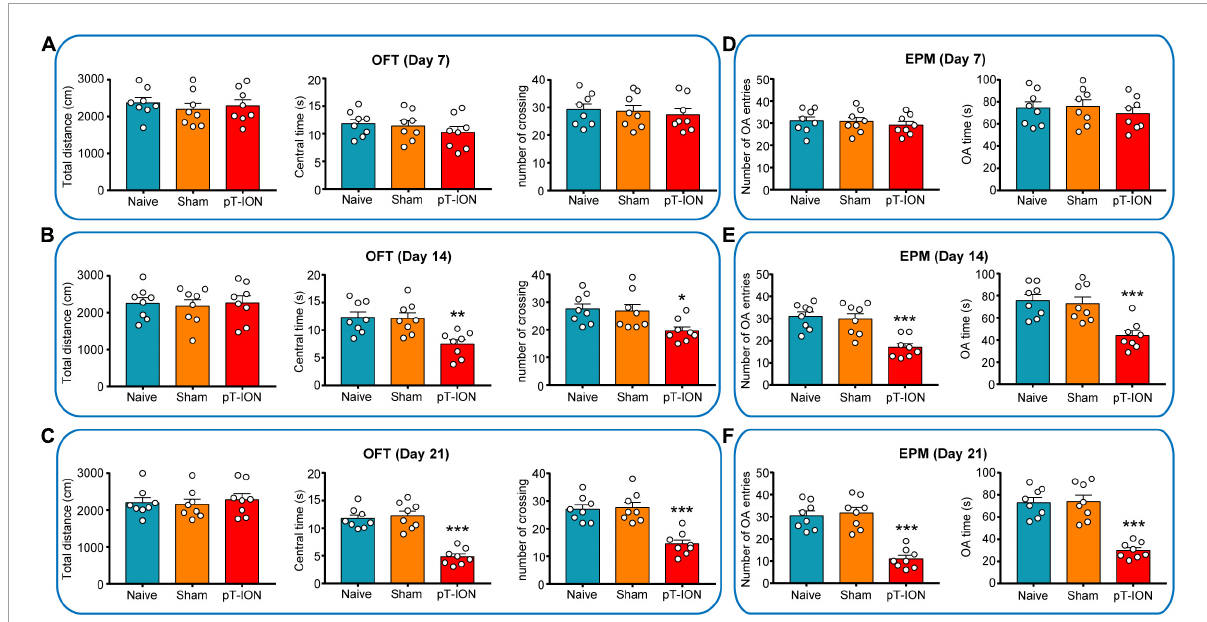
FIGURE2 Open-field test (OFT) and elevated plus-maze (EPM) test results of mouse at various time points. In the OFT, the total distance, central time, and number of crossing were measured on days 7 (A) , 14 (B) , and 21 (C) after pT-ION surgery. In the EPM test, the number of entries in the open arms (number of OA entries), time spent in the open arms (OA time) were measured on days 7 (D) , 14 (E) , and 21 (F) after pT-ION surgery. N = 8 mice/group, * P < 0.05, ** P < 0.01, and *** P < 0.001 vs. naive group, one-way ANOVA and Dunnett’s